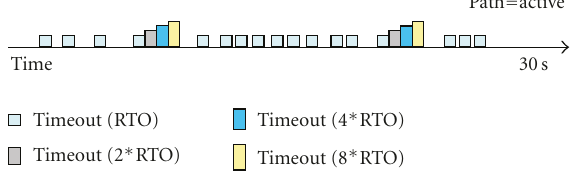
Figure 2: Original count algorithm leading to a mistaken evalua- tion of the path condition as active.